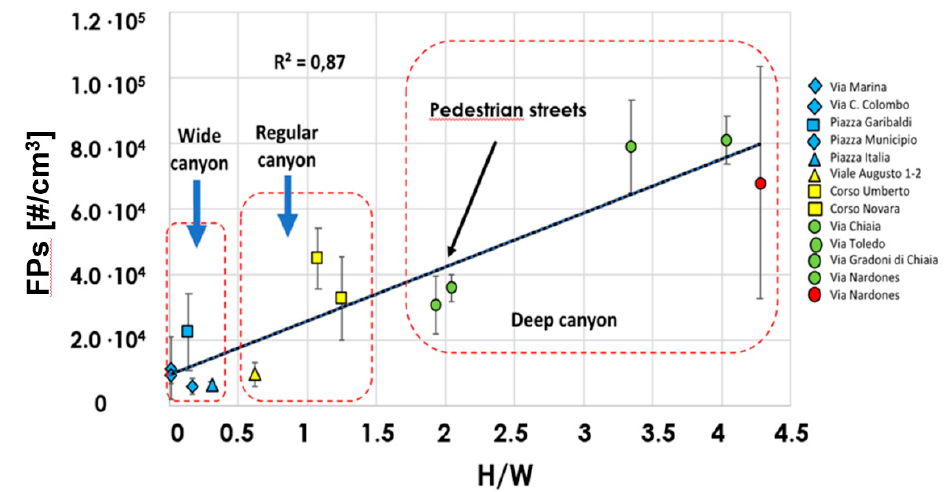
Figure 5. The effect of aspect ratio H/W on FPs concentration in Naples (green circles data are from this study, others are from [34]). study, others are from